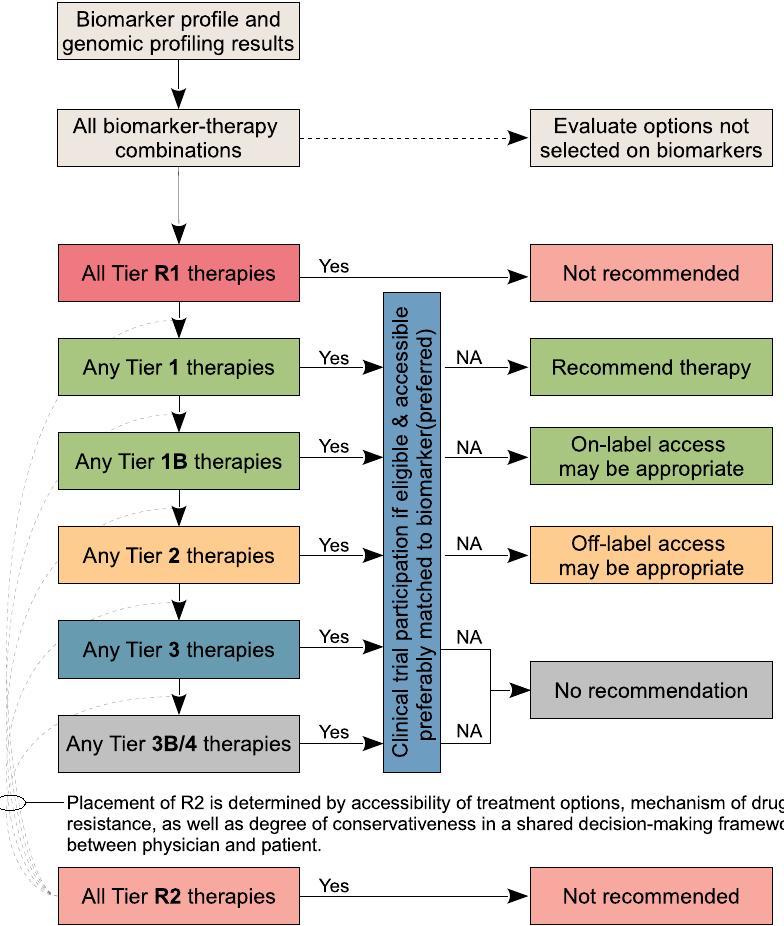
Fig. 3 Proposed cascade decision algorithm to support treatment recommendation. In general, participation in a clinical trials should always be considered as best practice. T1 therapies are readily accessible and are thus recommended with exception of a concomitant, high- level resistance biomarker being present (i.e., Tier R1) or known treatment failure due to previous exposure, intolerance, or toxicity to another drug in the same therapeutic class. Off-label use of T2 therapies may be considered appropriate in selected circumstances. T3/4 therapies are not generally recommended outside clinical trial settings, given lack of compelling clinical data to support its use. In exceptional circumstances where treatment options are limited in rare cancer types, off-label access of lower-tier drugs may be appropriate. NA: therapy not